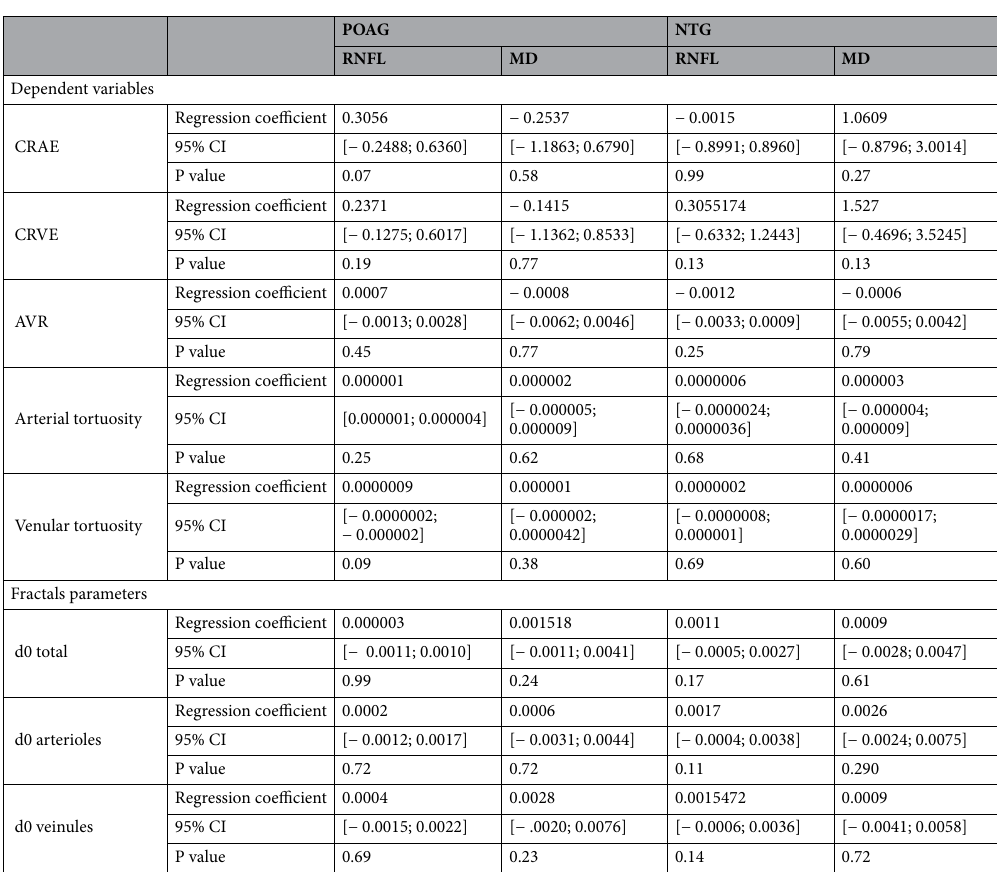
Table 3. Univariable associations between artery/veins characteristics or fractals parameters and retinal nerve fiber layer (RNFL) or mean deviation (MD), by group. AVR arteriole-to-venule ratio, CI 95% confidence interval, d0 fractal dimension, CRAE central retinal arterial equivalent, CRVE central retinal venular equivalent, NTG normal tension glaucoma, POAG primary open angle